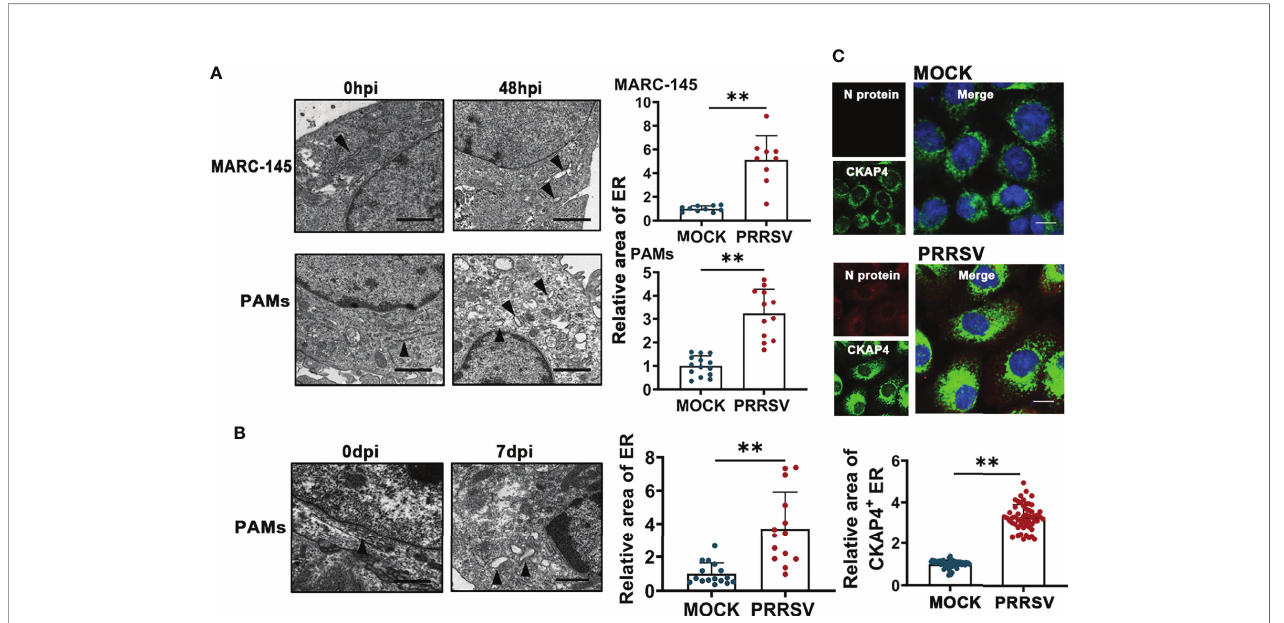
FIGURE 1 | PRRSV infection results in ER expansion. (A) Representative TEM images of MARC-145 cells and PAMs infected with or without PRRSV (MOI=5) for 48 h and quanti fi cation of ER area (n>10). Scale bars: 2 m m. ** P <0.01, Wilcox test. (B) Representative TEM images of PAMs collected from pigs infected with or without PRRSV for 7 days in vivo . Black arrows indicate the subcellular localization of ER. The area of ER was quanti fi ed (n>10). Scale bars: 2 m m. ** P <0.01, Wilcox test. (C) Immunostaining of CKAP4 (Green) and PRRSV N (Red) in MARC-145 cells infected with or without PRRSV (MOI=2) for 48 h. Representative confocal images were shown, and the area of CKAP4 + ER was quanti fi ed (n>50). Scale bars: 20 m m. ** P <0.01, Wilcox